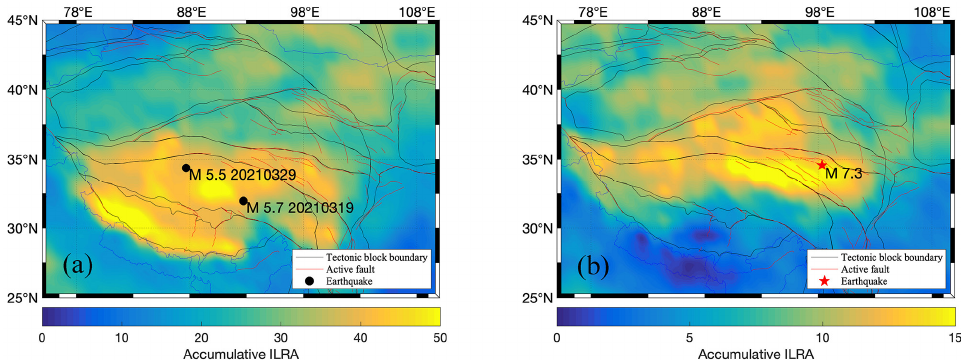
Figure 12. Spatial distribution of accumulative ILRA variation prior to ( a ) the two moderate earth- quakes in the Qiangtang tectonic block and ( b ) the Madoi M 7.3 earthquake.